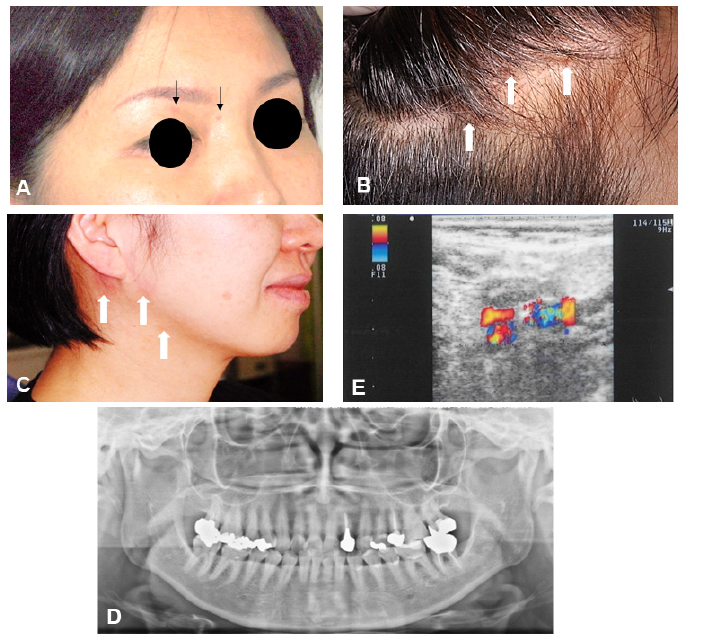
Figure 1. ( A – C ): The patient had a burning pain, edematous erythema and vesicles, and swelling around the eyelids and on the scalp after a period of days and consulted with a neurosurgeon. ( D ): Panoramic radiograph shows mild resorption of mandibular condyle on the right side. ( E ): Ultrasonography showed lymphadenitis.